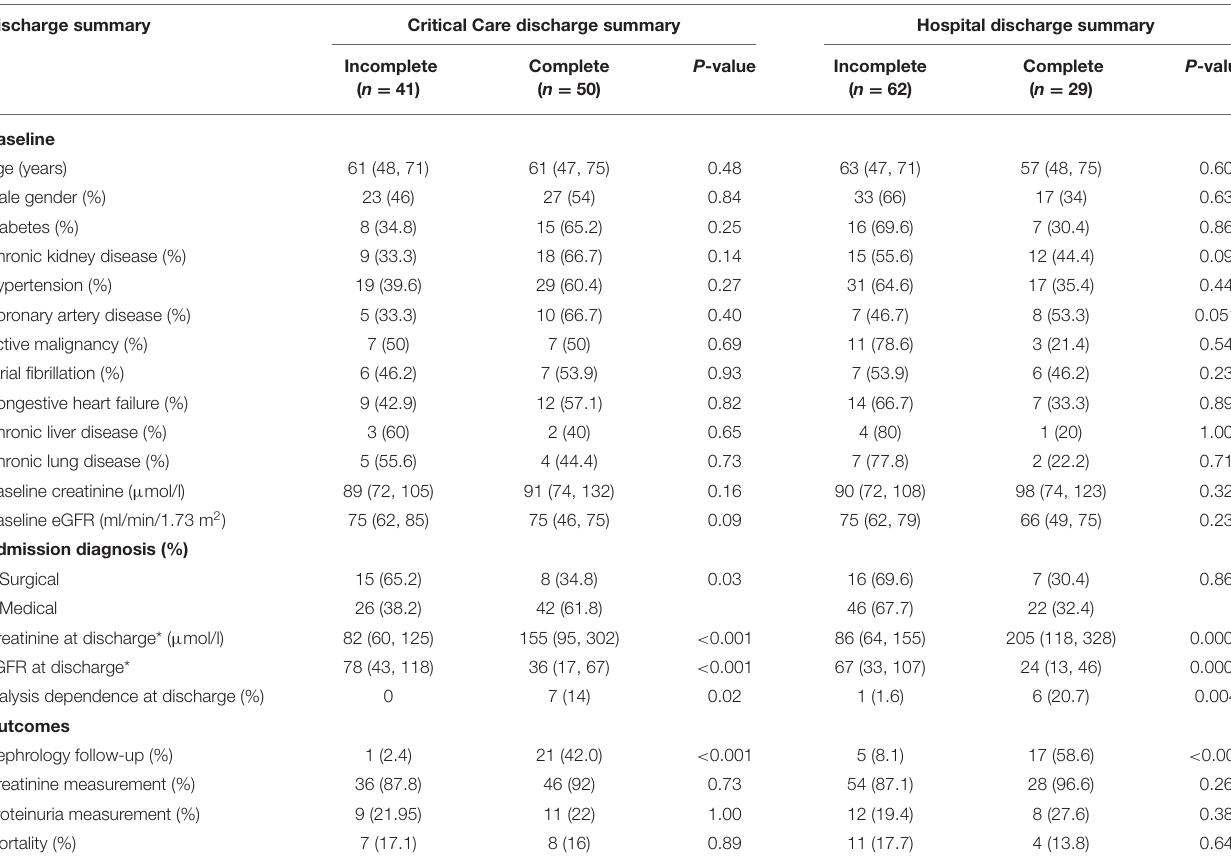
TABLE 3 | Characteristics and outcomes by completeness of discharge